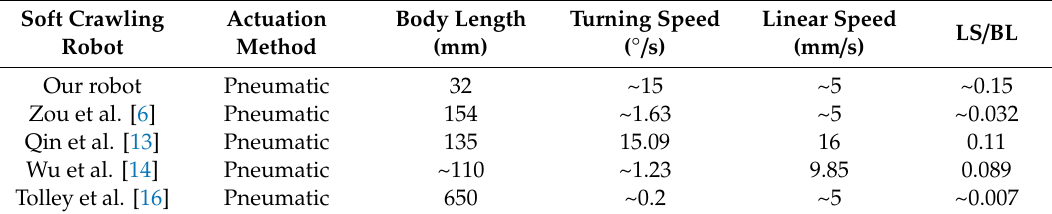
Table 3. A Comparison of Di ff erent Soft Crawling